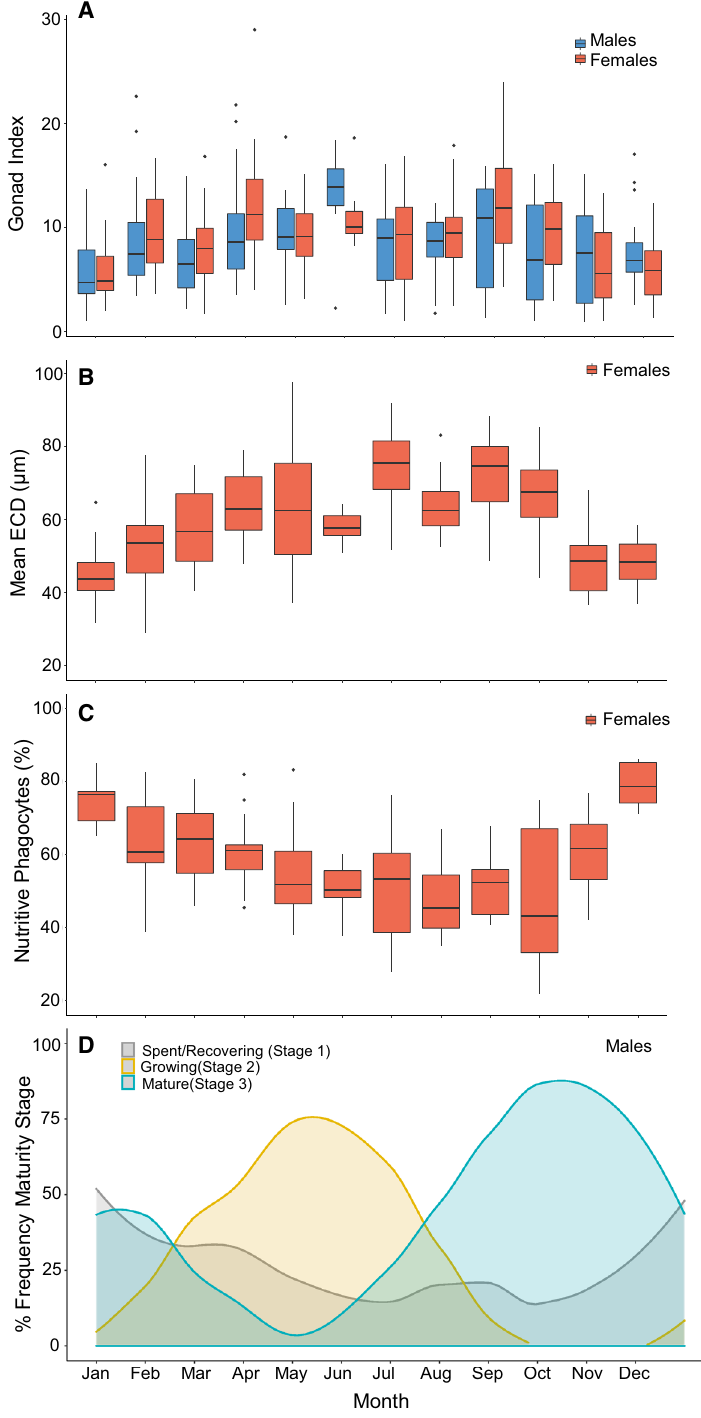
Figure 2. Monthly changes for Sterechinus neumayeri in ( A ) gonad index for males (blue) and females (red); ( B ) mean equivalent circular diameter (ECD) of oocytes present in female gonads; ( C ) percentage (%) of gonad tissue in females composed of nutritive phagocytes; ( D ) percentage frequency (%) of male gonad maturity stages where frequencies are smoothed by the function y ~ x using the local regression smoother (LOESS) method. The smoothing span was chosen to reflect seasonal changes. Data as box plots are displayed with the central line in the boxes representing the median value, the upper and lower hinges representing the 25th and 75th percentiles, and the upper/lower whiskers representing the largest/smallest value, no further than 1.5 times the interquartile range from the hinge. All data outside these ranges are plotted as